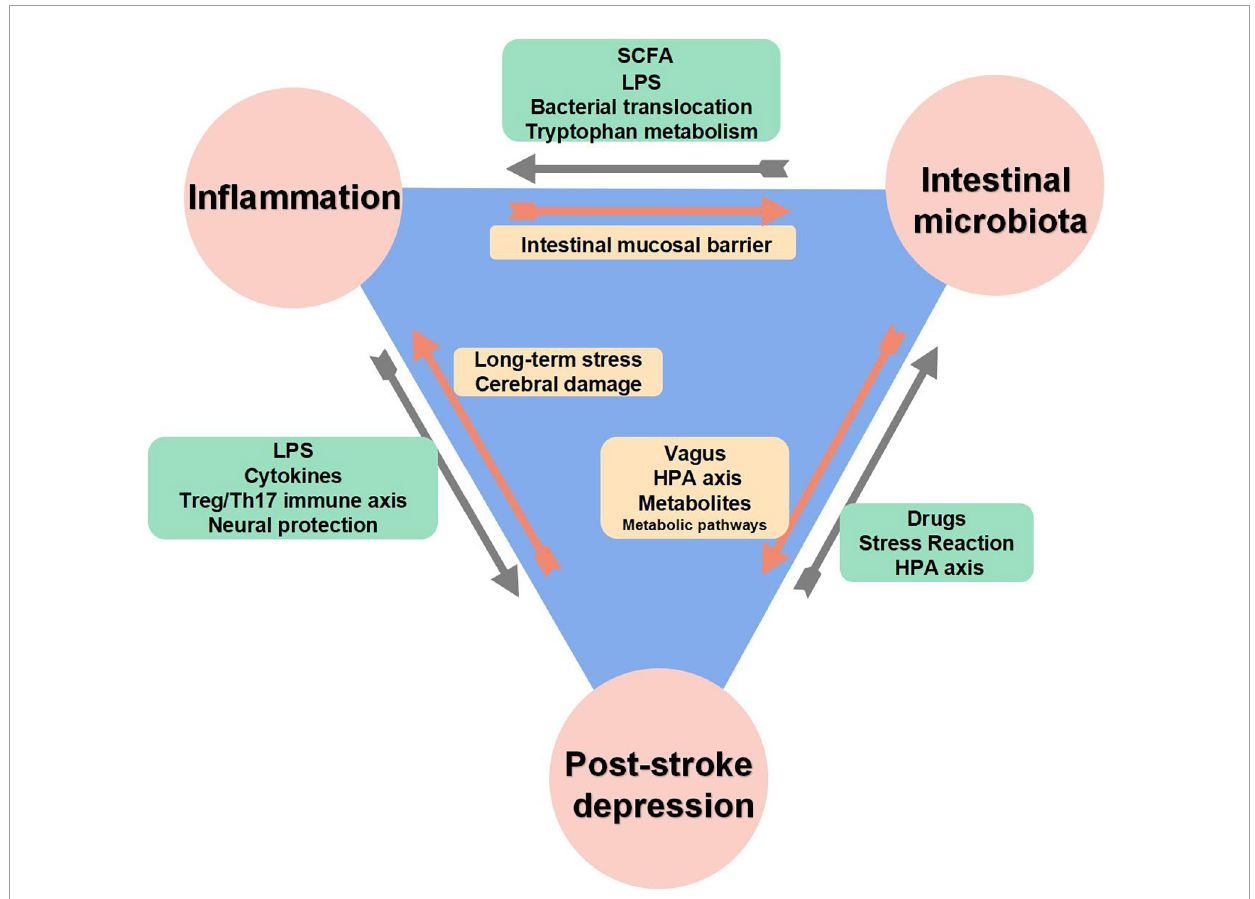
FIGURE1 The interaction between inflammation, intestinal microbiota and post-stroke depression